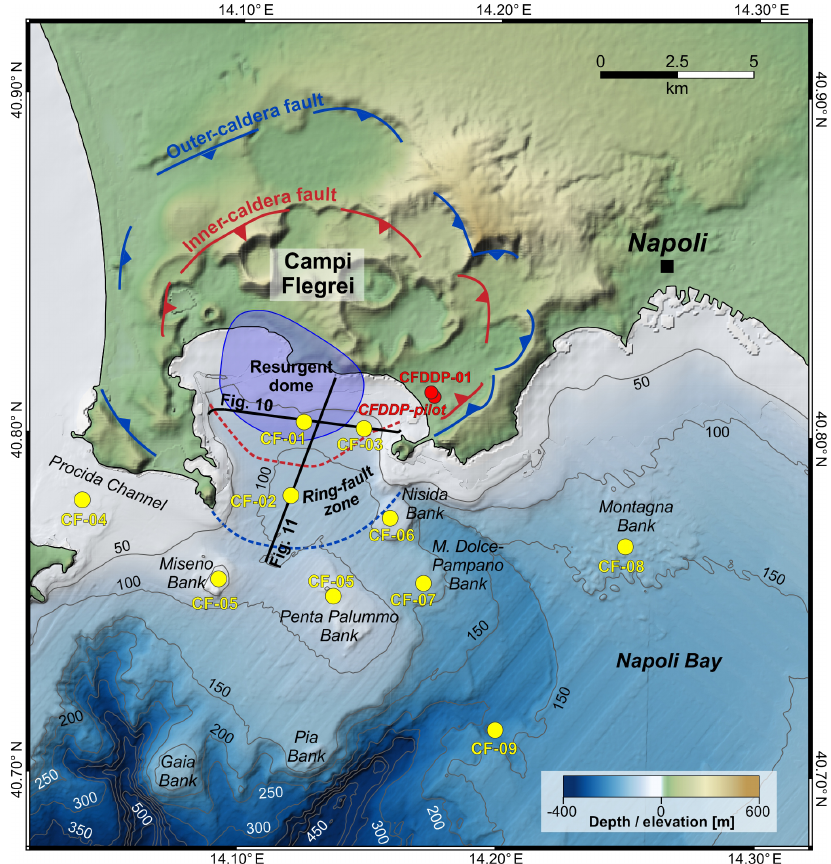
Figure 2. Digital Terrain Model (DTM) of the Campi Flegrei caldera (CFc) showing the structural border(s) and the offshore ring-fault– resurgent-dome system associated with the eruption of the Neapolitan Yellow Tuff (NYT) ( ∼ 15ka), along with the most prominent subaerial and submerged volcanic morphologies of Napoli Bay. Location of seismic reflection profiles illustrated in Figs. 10 and 11 is also